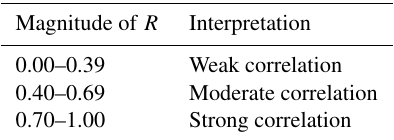
Table 2. Interpretation of the correlation coefficient ( R ), as de- scribed in Schober et al. (2018)